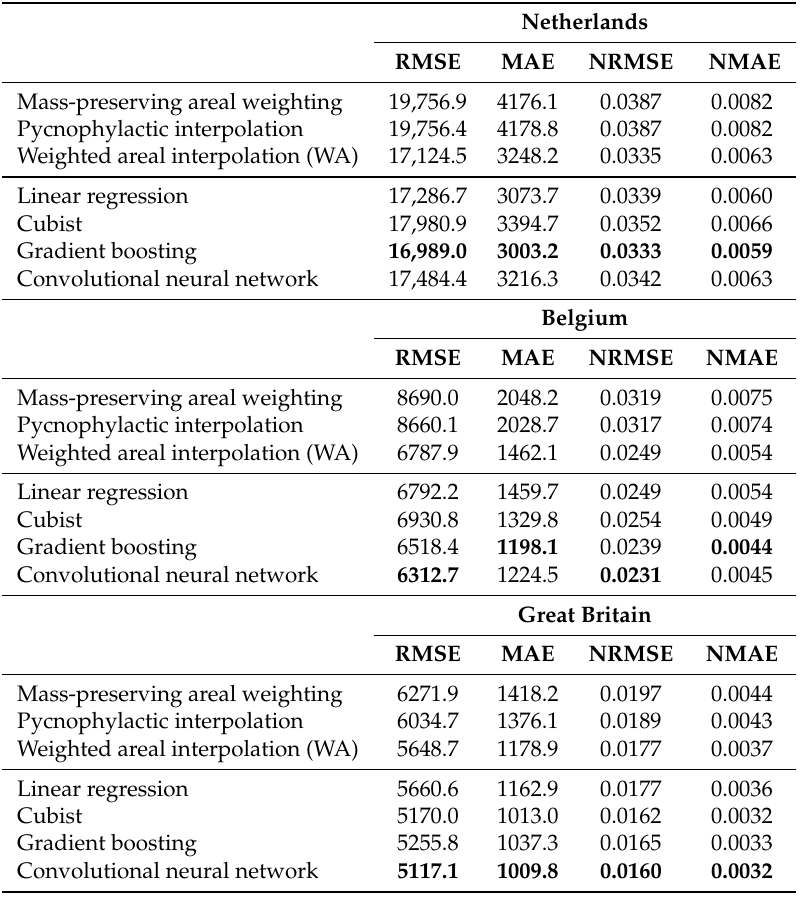
Table 1. Results obtained with different disaggregation